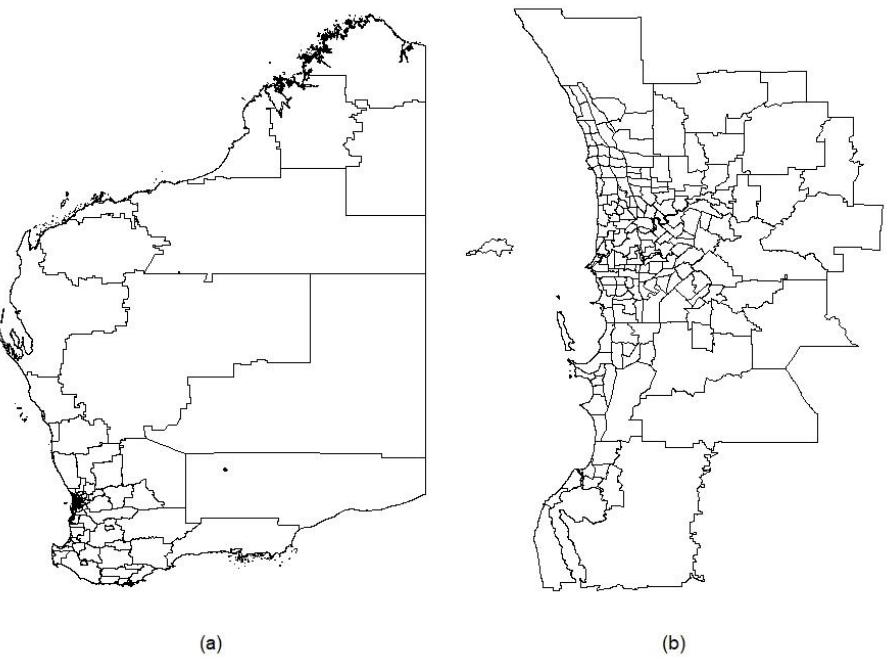
Figure 1. 2016 Statistical Areas Level 2 (SA2) boundaries in ( a ) Western Australia and ( b ) metropolitan Perth.